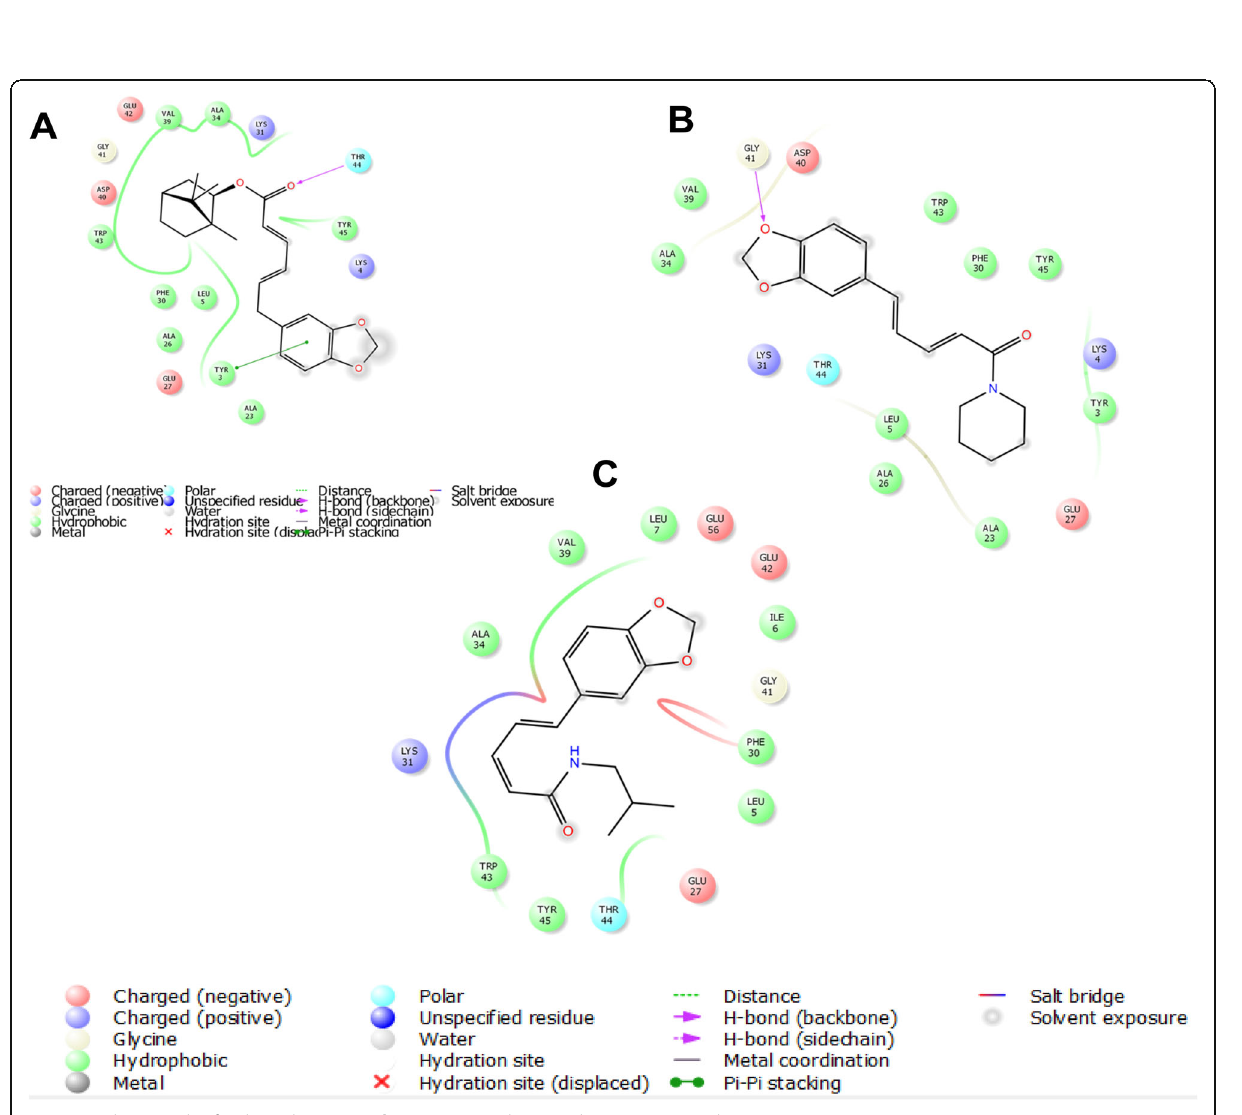
Fig. 3 Docking result of a (bornyl piperate), b (piperine) and c (piperlonguminine) with NF- κ B (PDB: